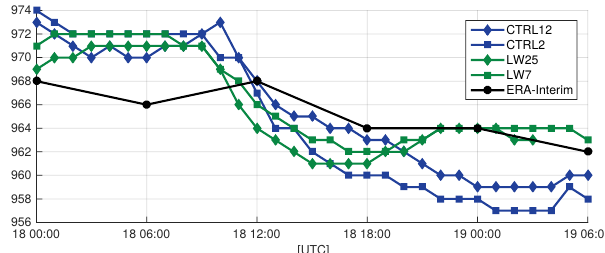
Figure 4. Core pressure evolution of the Kyrill II wind storm from 18 January 2007, 00:00 UTC onwards. The black dots represent the 6-hourly ERA-Interim data, the blue diamonds the CTRL12 and the blue squares CTRL2. The green diamonds show the storm core pressure for the 25km grid-spacing simulation (LW25) performed in Ludwig et al. (2015), and the green squares their simulation with a horizontal grid spacing of 7km